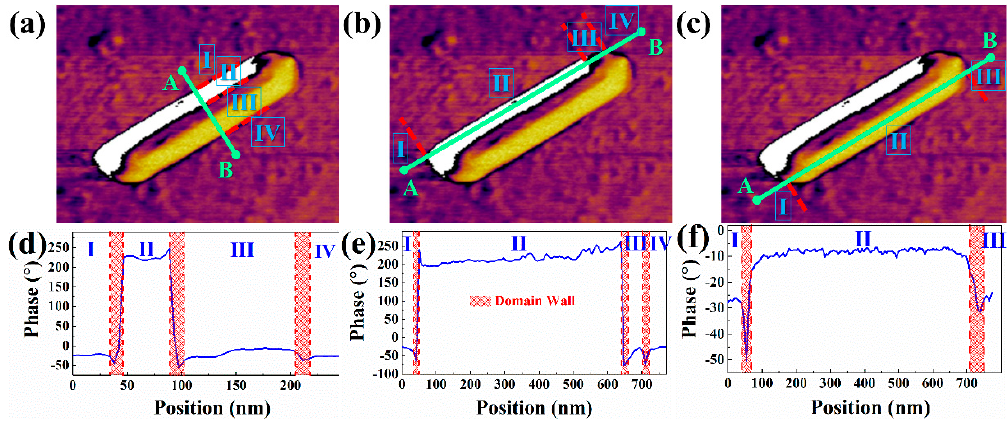
Figure 3. Thephase polarization direction versus position curves ( d – e ) and the corresponding position is marked in ( a – c ).